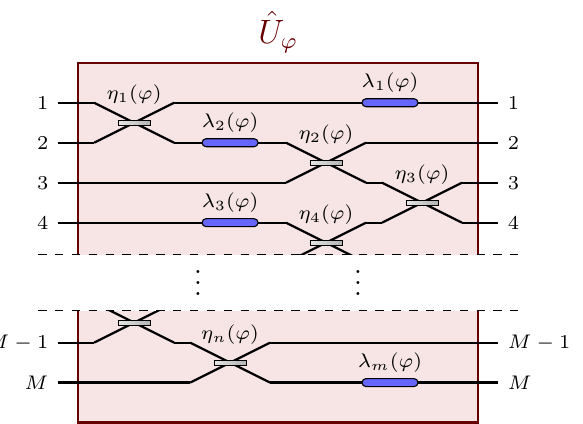
Figure 1. Example of a passive and linear network ˆ U ϕ which depends on a single global parameter ϕ . The parameter can be thought of as a physical property of an external agent (e.g., tempera- ture, electromagnetic field) which affects multiple components, possibly of different natures, of the network [42,43]. Reprinted with permission from ref. [42], © 2021 The